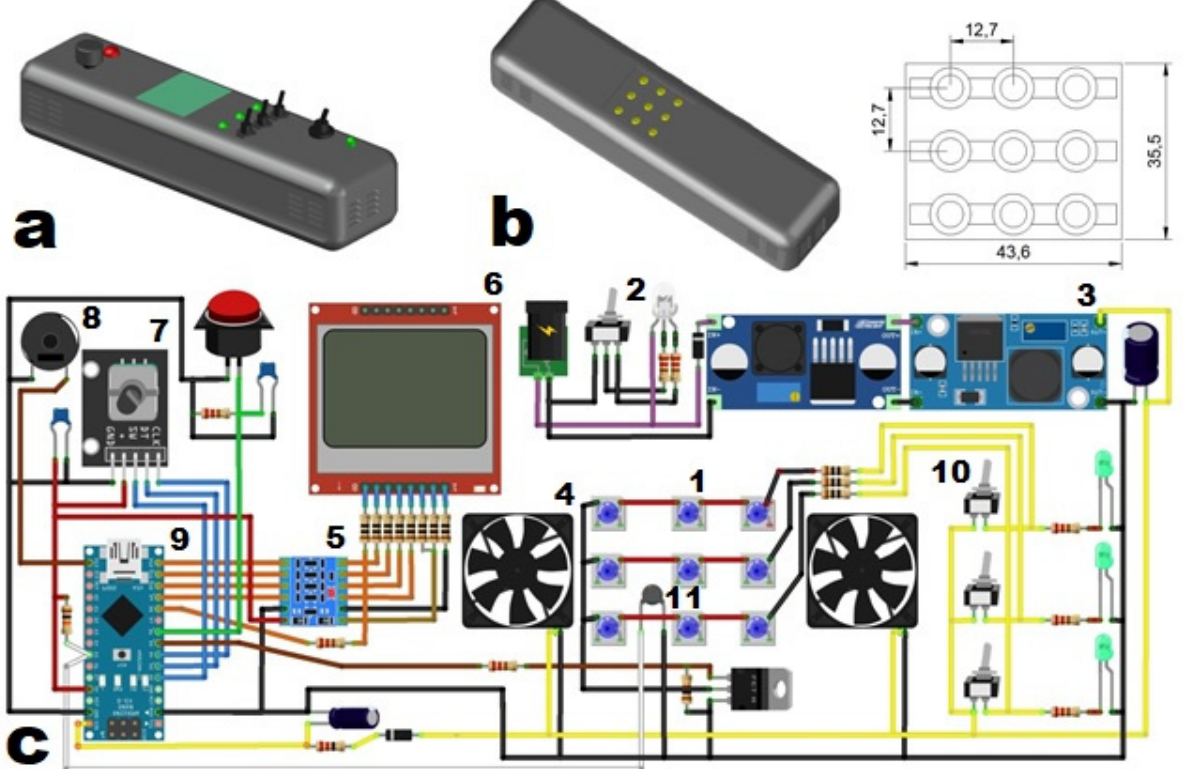
Figure 4. UV light source based on LEDs: ( a ) total view; ( b ) LED layout, ( c ) circuit diagram: 1 —DRP-5WLG45UV365 LEDs; 2 —power connector with reverse polarity protection, toggle switch and circuit power indication; 3 —adjustable DC-DC voltage converters; 4 —ventilators; 5 —bidirectional 4-channel converter of logic signal levels; 6 —graphic LCD display Nokia 5110; 7 —encoder; 8 —buzzer; 9 —Arduino Nano 3.0 microcontroller; 10 —toggle switch; 11 —thermistor.